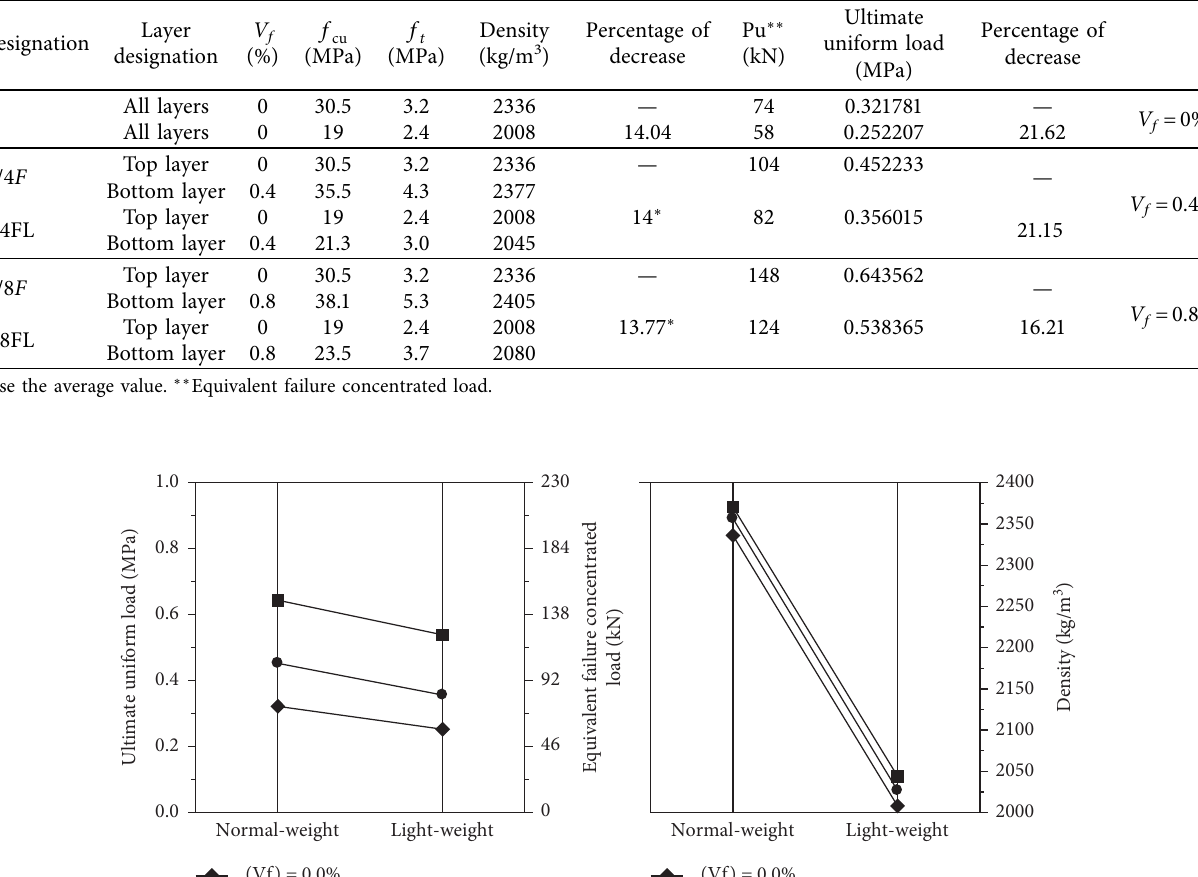
Table 11: Effect of replacing normal-weight aggregate by lightweight aggregate on ultimate uniform load and density.